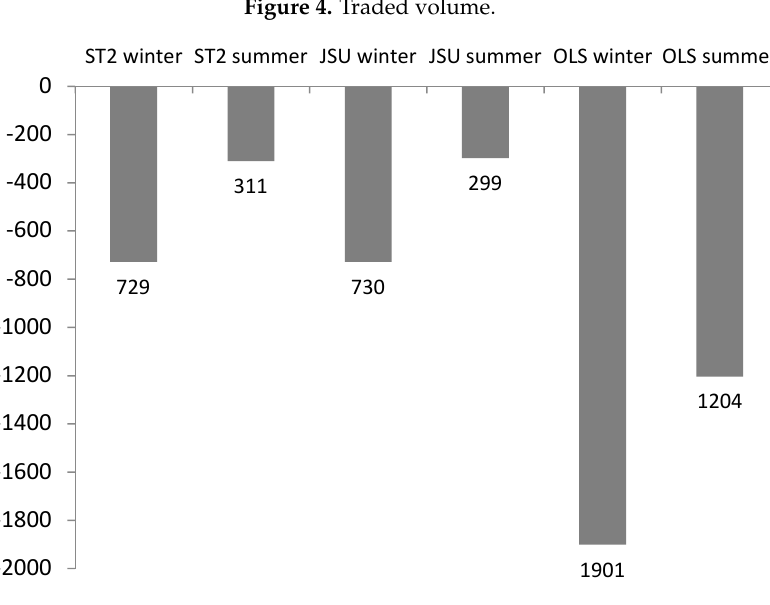
Energies 2018 , 11 , x FOR PEER REVIEW